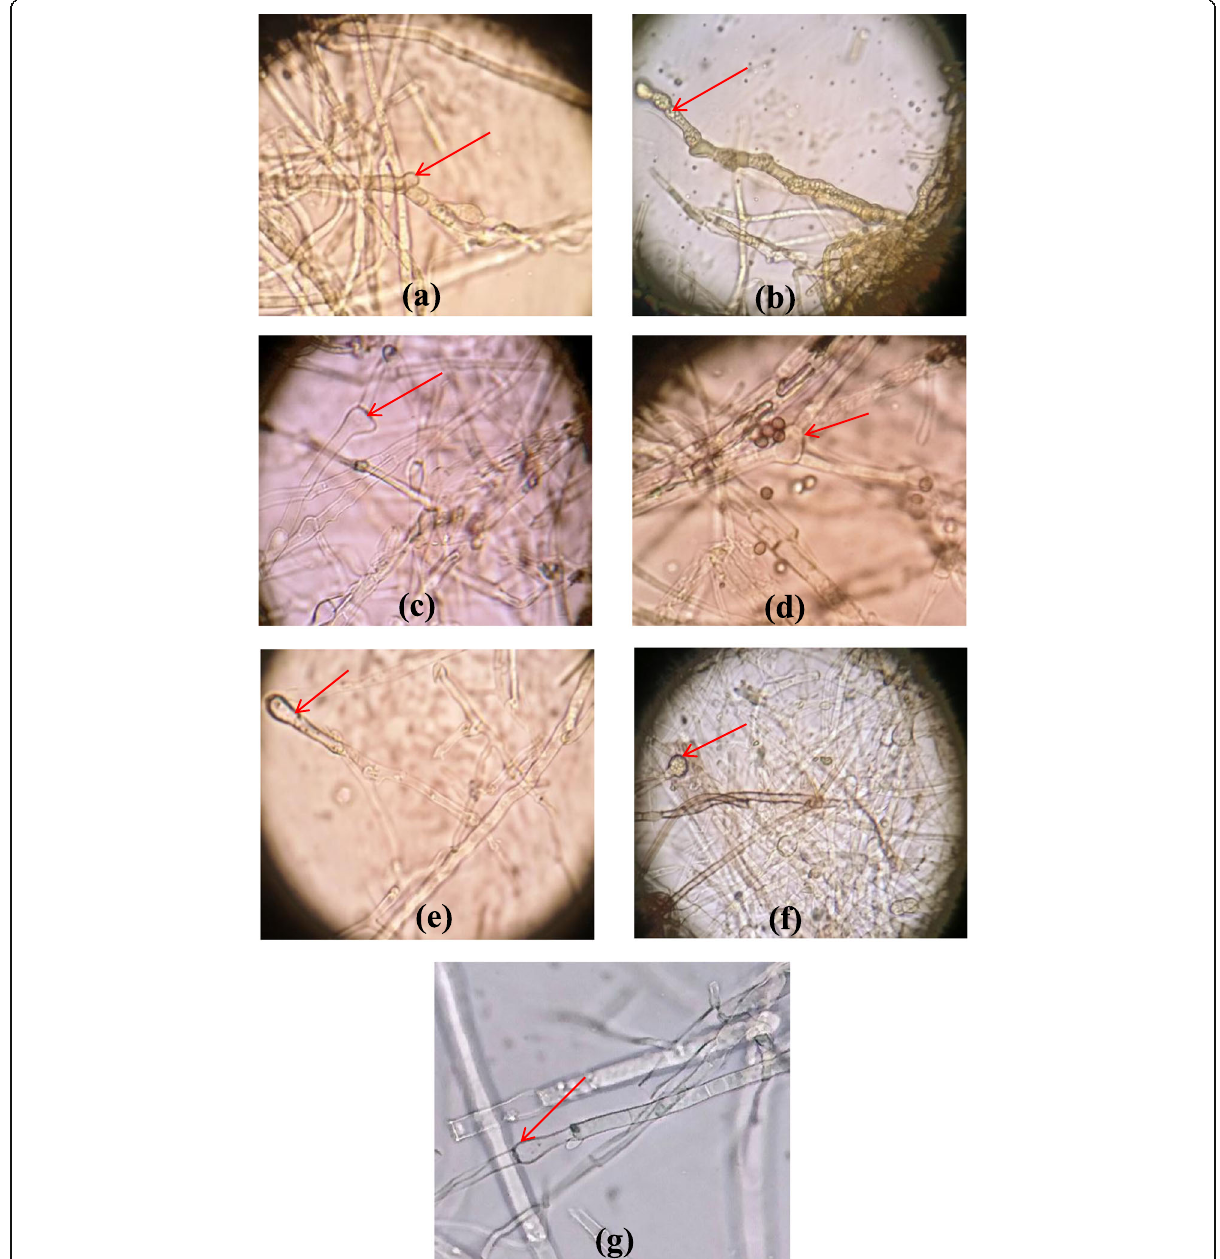
Fig. 3 Changes in the mycelial growth of D . necatrix after interaction with fungal root endophytes [ a Fusarium equiseti strain M1, b Talaromyces aculeatus strain Ap, c Neocosmospora perseae strain G, d Aspergillus aculeatus strain C2, e Crinipellis tabtim strain M8, f Fusarium circinatum strain K3, and g control] isolated from apple and other